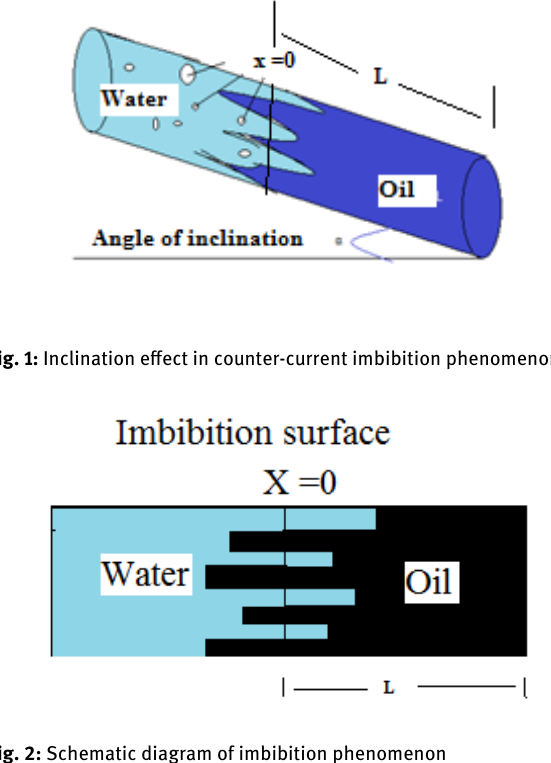
Fig. 2: Schematic diagram of imbibition